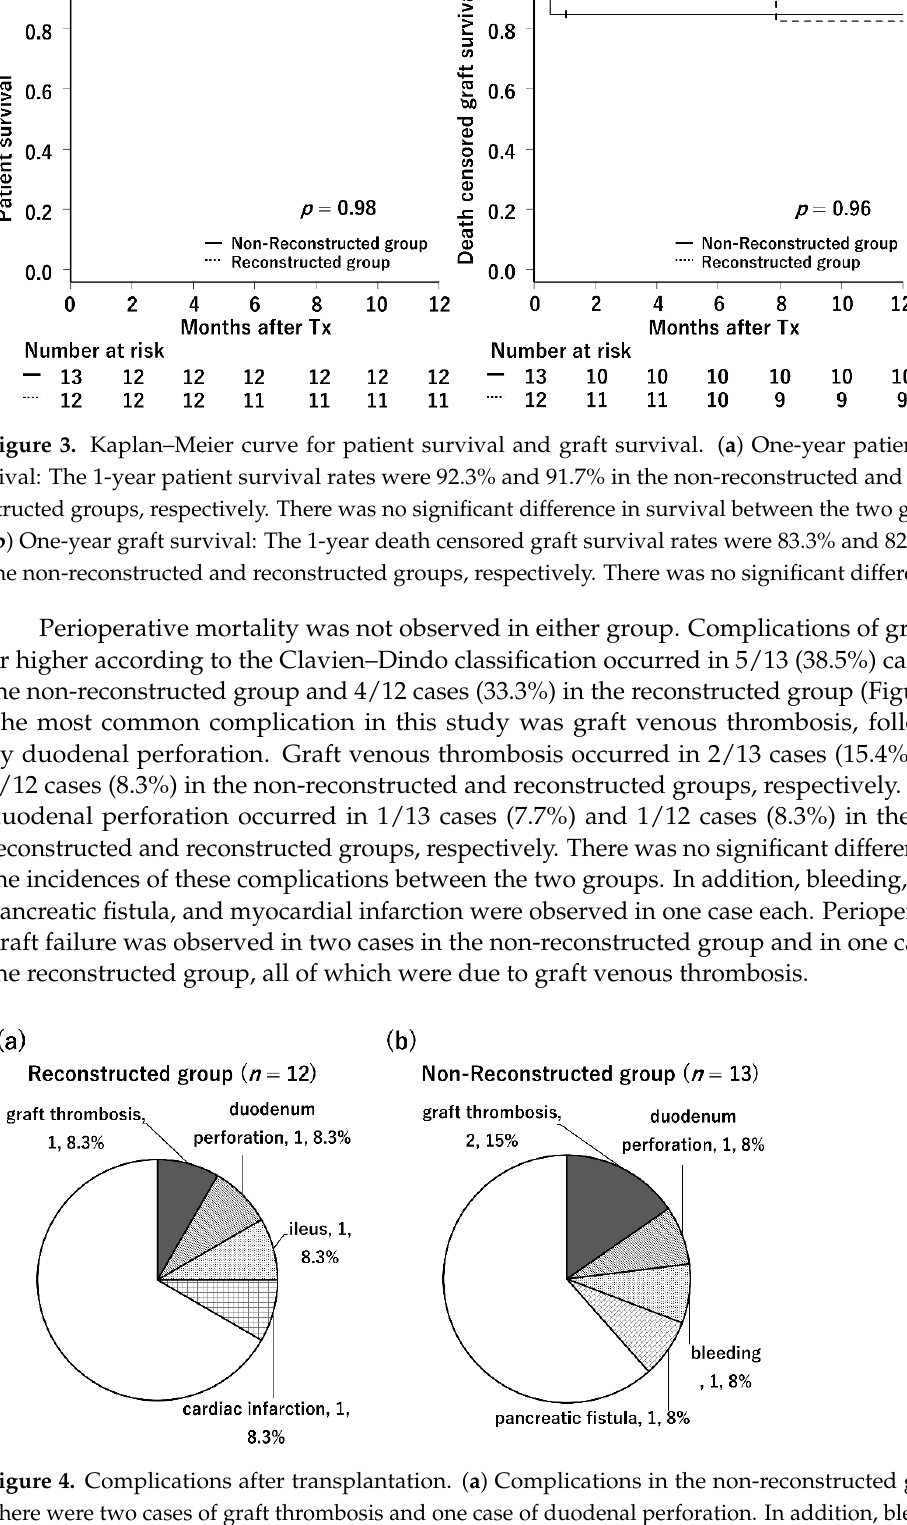
Figure 4. Complications after transplantation. ( a ) Complications in the non-reconstructed group: There were two cases of graft thrombosis and one case of duodenal perforation. In addition, bleed- ing and pancreatic juice leakage were observed in one case each. ( b ) Complications in the recon- structed group: There was one case of graft thrombosis and one case of duodenal perforation. In addition, one case of ileus and one case of myocardial infarction were observed.